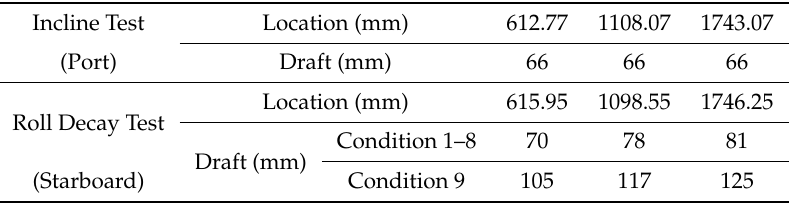
Figure A1. Position of sensors and weights in the model. Table A2. Draft and draft measuring locations from